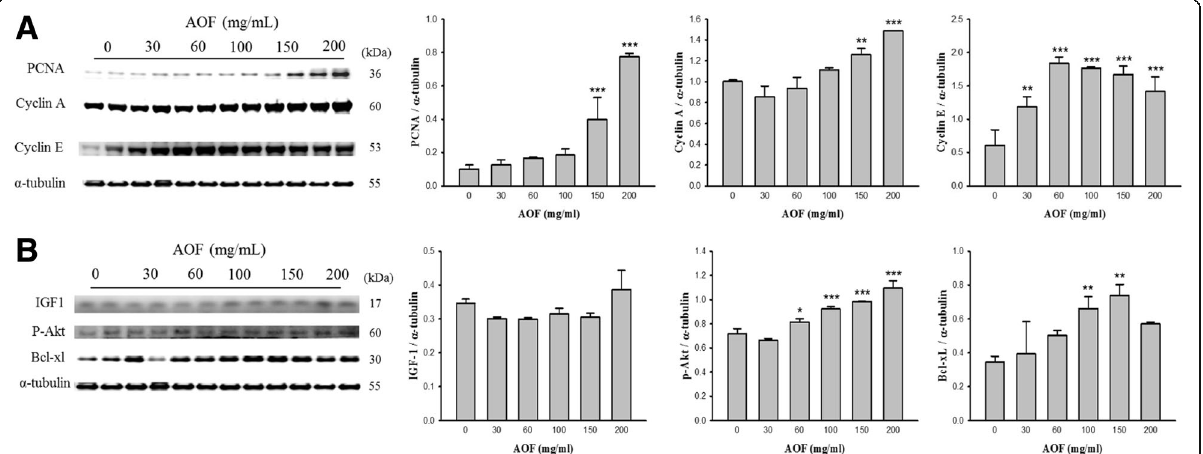
Fig. 1 The regeneration of dissected sciatic nerves in the chambers filled with AOF. Sprague-Dawley rats weighing 220 ± 20 g underwent silicone chamber placement. The chambers in the right legs were filled with various concentrations of AOF as indicated. The sciatic nerves from the chamber in rats with surgery were taken. As shown by western blot analyses, AOF treatment upregulated PCNA, cyclin A, cyclin E ( a ) and the IGF- 1, p-Akt, Bcl-XL ( b ) in a dose-dependent manner. α -tubulin was used as a loading control